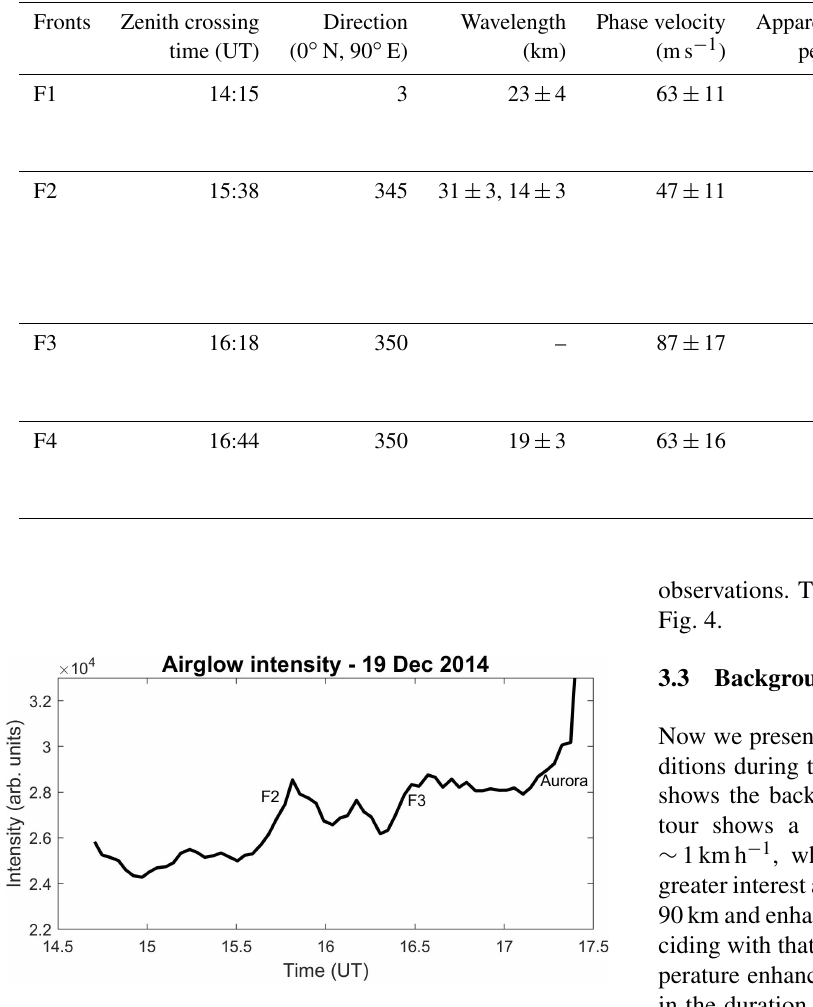
Figure 6. Zenith intensity time series from the average of 16 × 16 pixels over the zenith of the raw OH